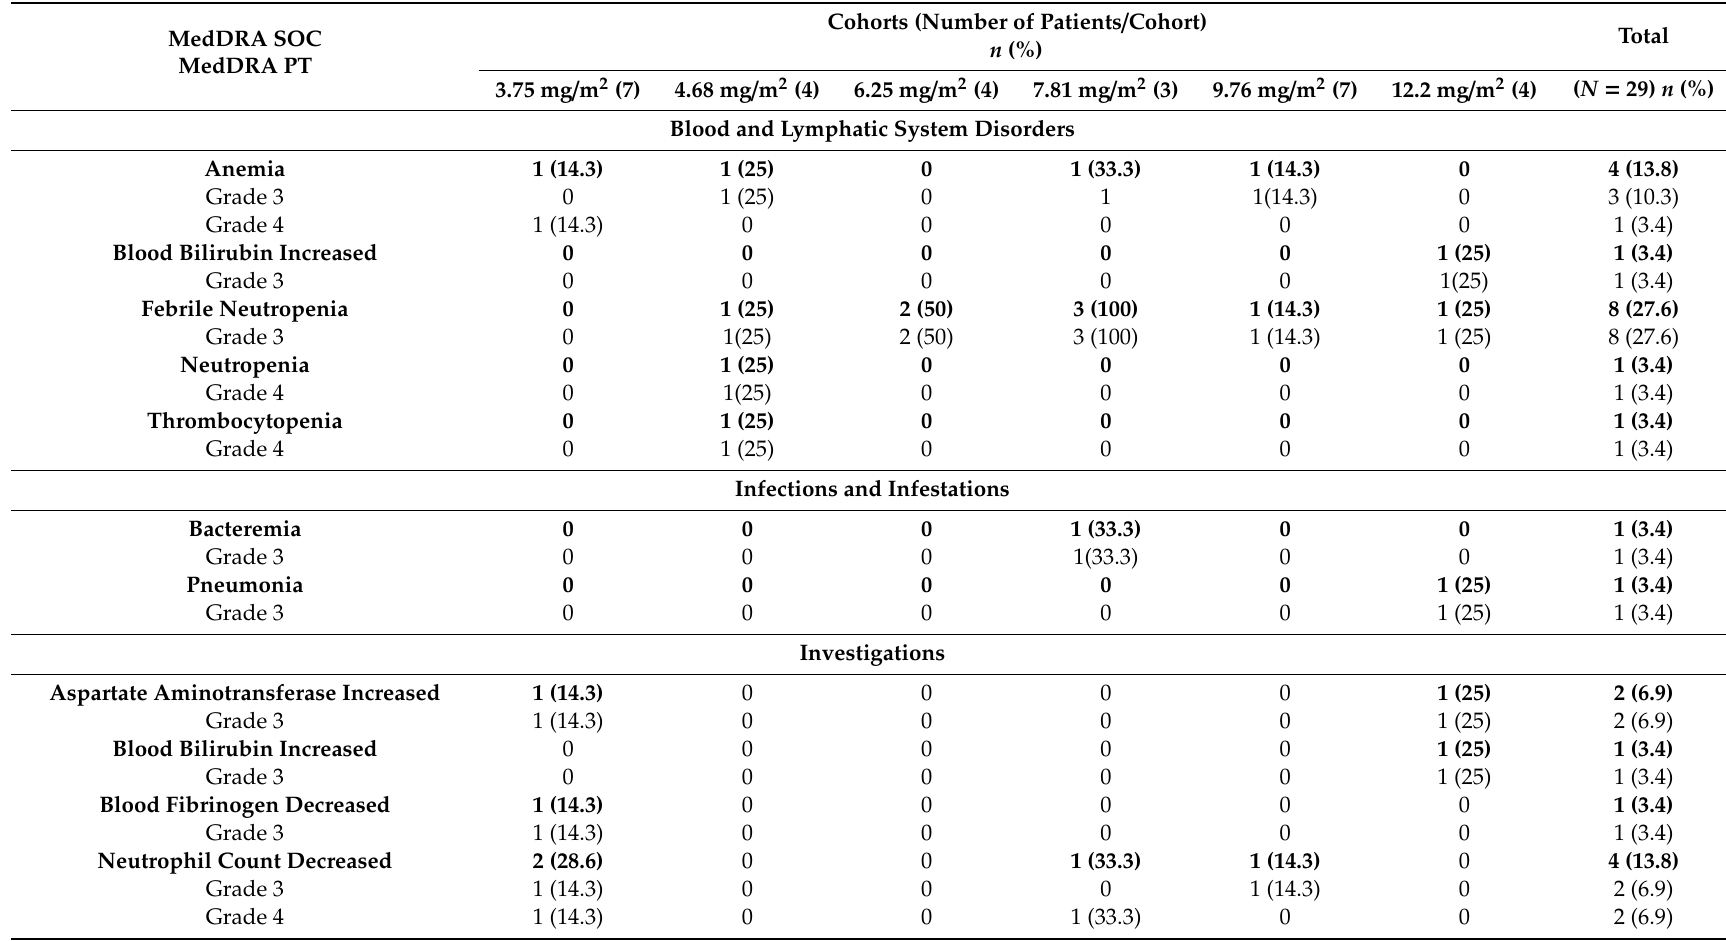
Table 2. Incidence of OXi4503-related Grade 3–4 AEs (adverse events) occurring in study OX1222 patients treated with OXA—by MedDRA